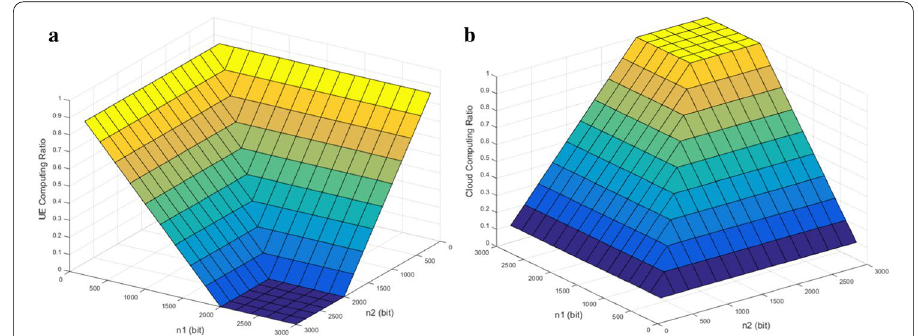
Fig. 7 Computing ratios with different value of receive capacity in mode 2. a UE computing ratio with different value of n 1 , n 2 in mode 2; b Cloud computing ratio with different value of n 1 , n 2 in mode